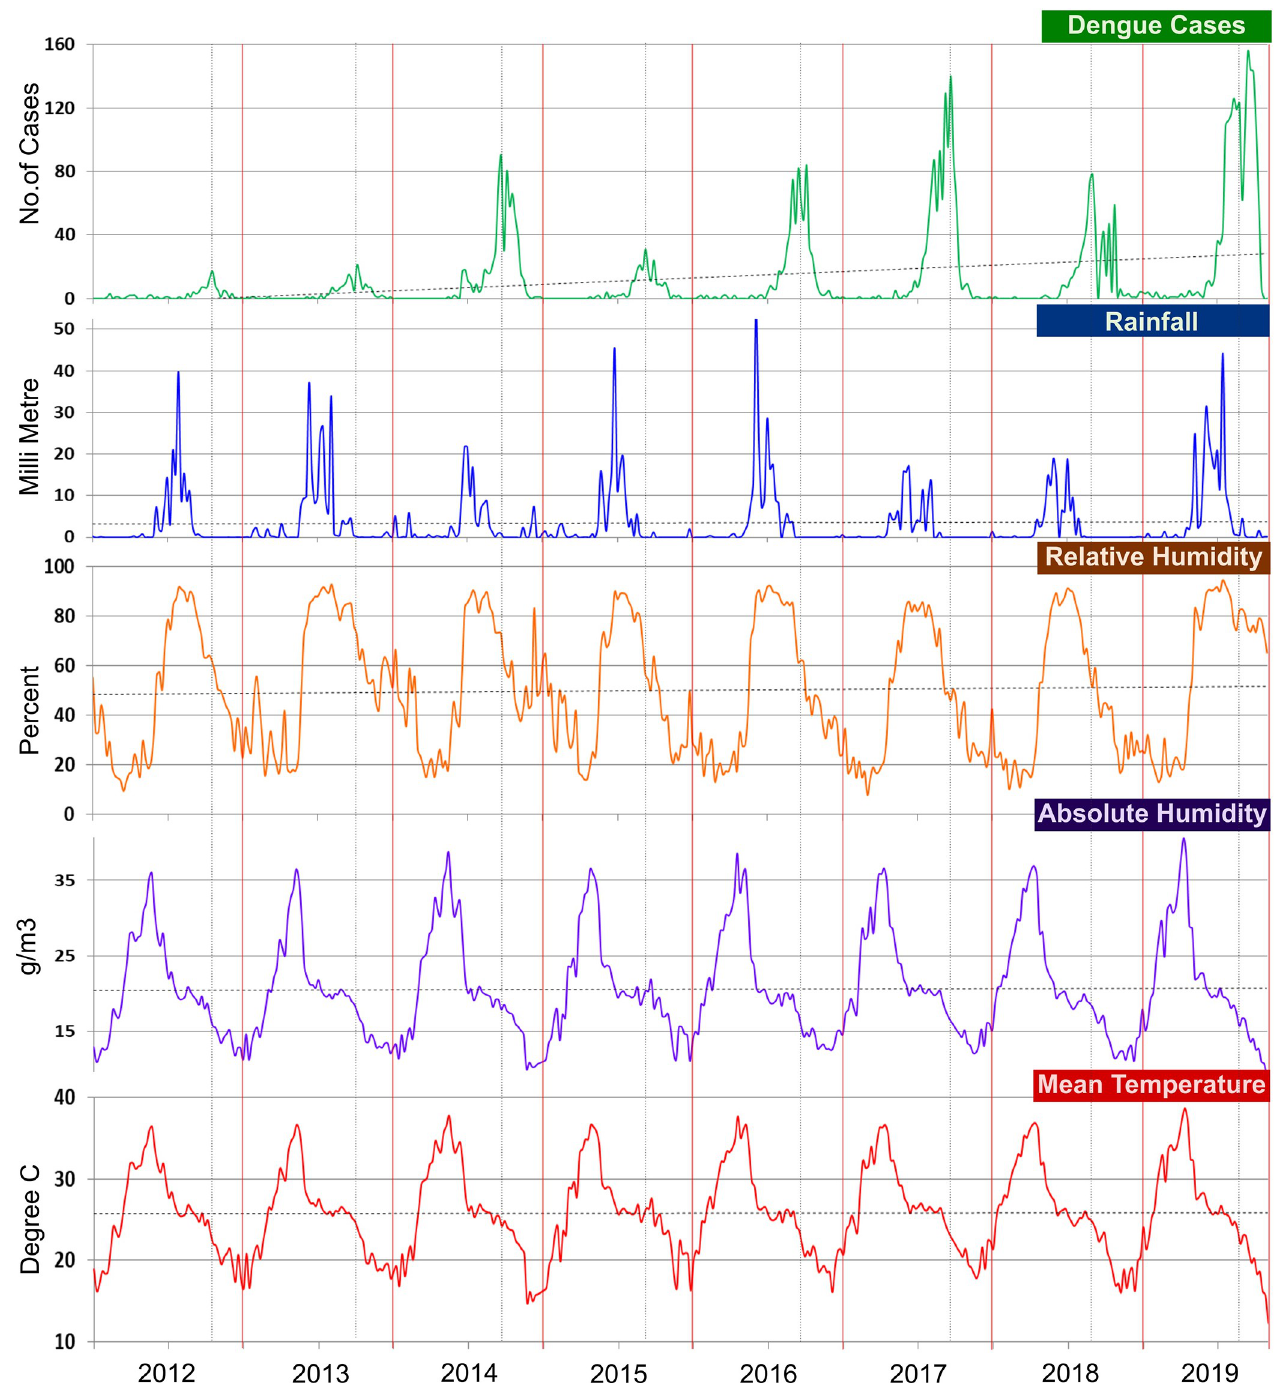
Fig 4. Time–series plots of weekly dengue cases, weekly cumulative rainfall, relative humidity, absolute humidity and mean temperature (2012–2019). correlations with weakly dengue cases at different time lags (S3 Fig). A significant correlation between dengue and rainfall ( r 2 = 0.510), humidity ( r 2 = 0.554), diurnal temperature range ( r 2 = 0.601) and temperature ( r 2 = 0.599) were observed at 12, 8, 9 and > 20 weeks lag respectively (S3 Fig).